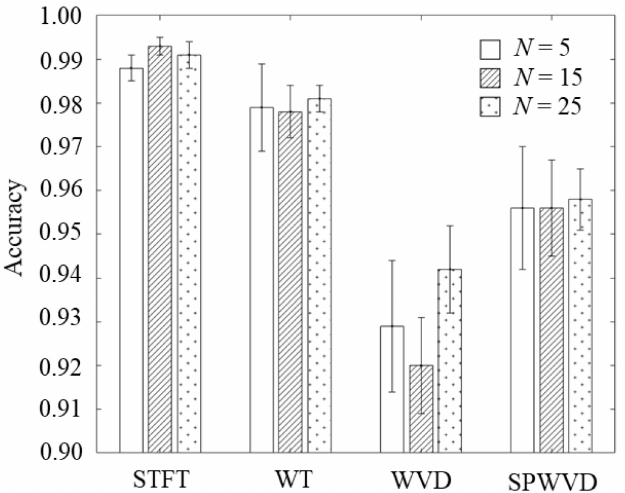
Figure 10. Comparison of identification accuracies using various types of time-velocity